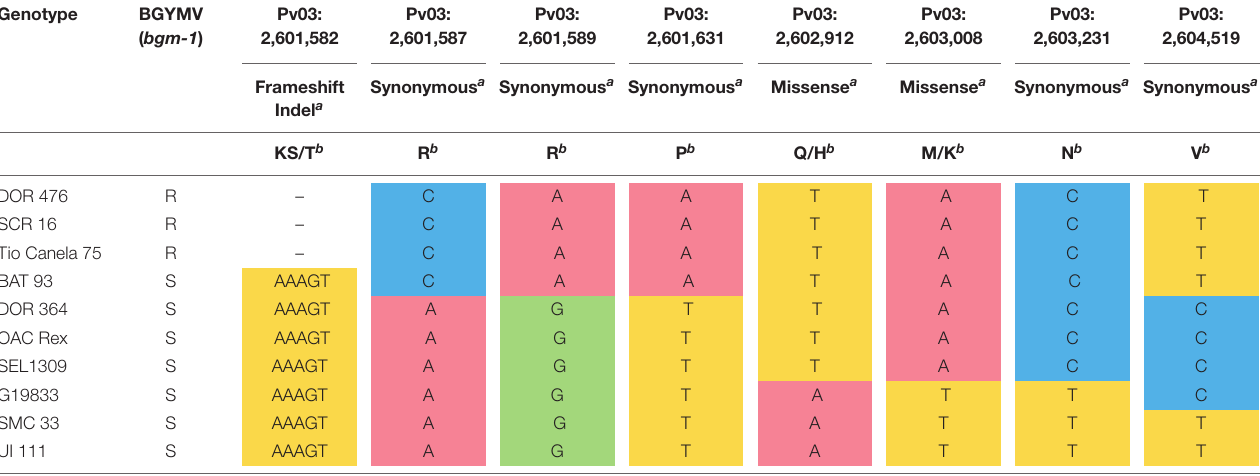
a Variant type. b Amino-acid substitutions in protein-coding